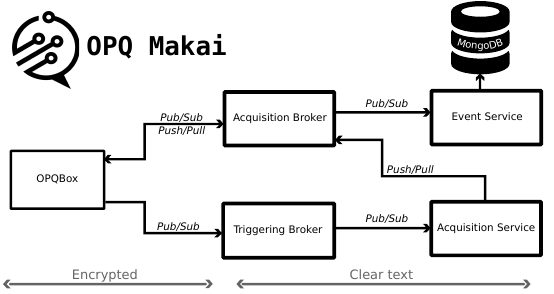
Figure 4. Makai component